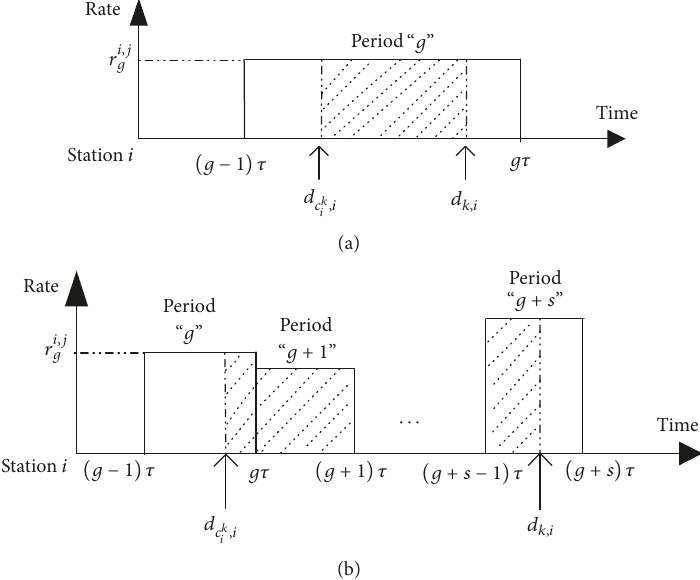
Figure 2: The departure of two consecutive trains; (a) trains 𝑘 and 𝑐 𝑘 𝑖 depart in the same time period; (b) trains 𝑘 and 𝑐 𝑘 𝑖 depart in different time